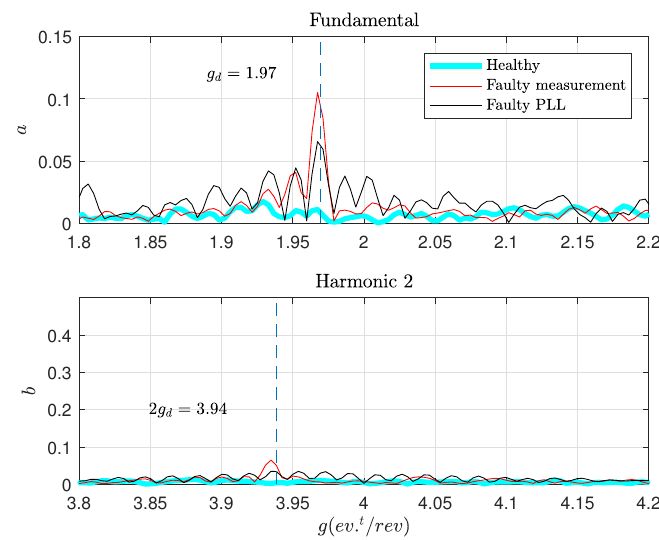
Figure 12. Zoom around fault components in angular